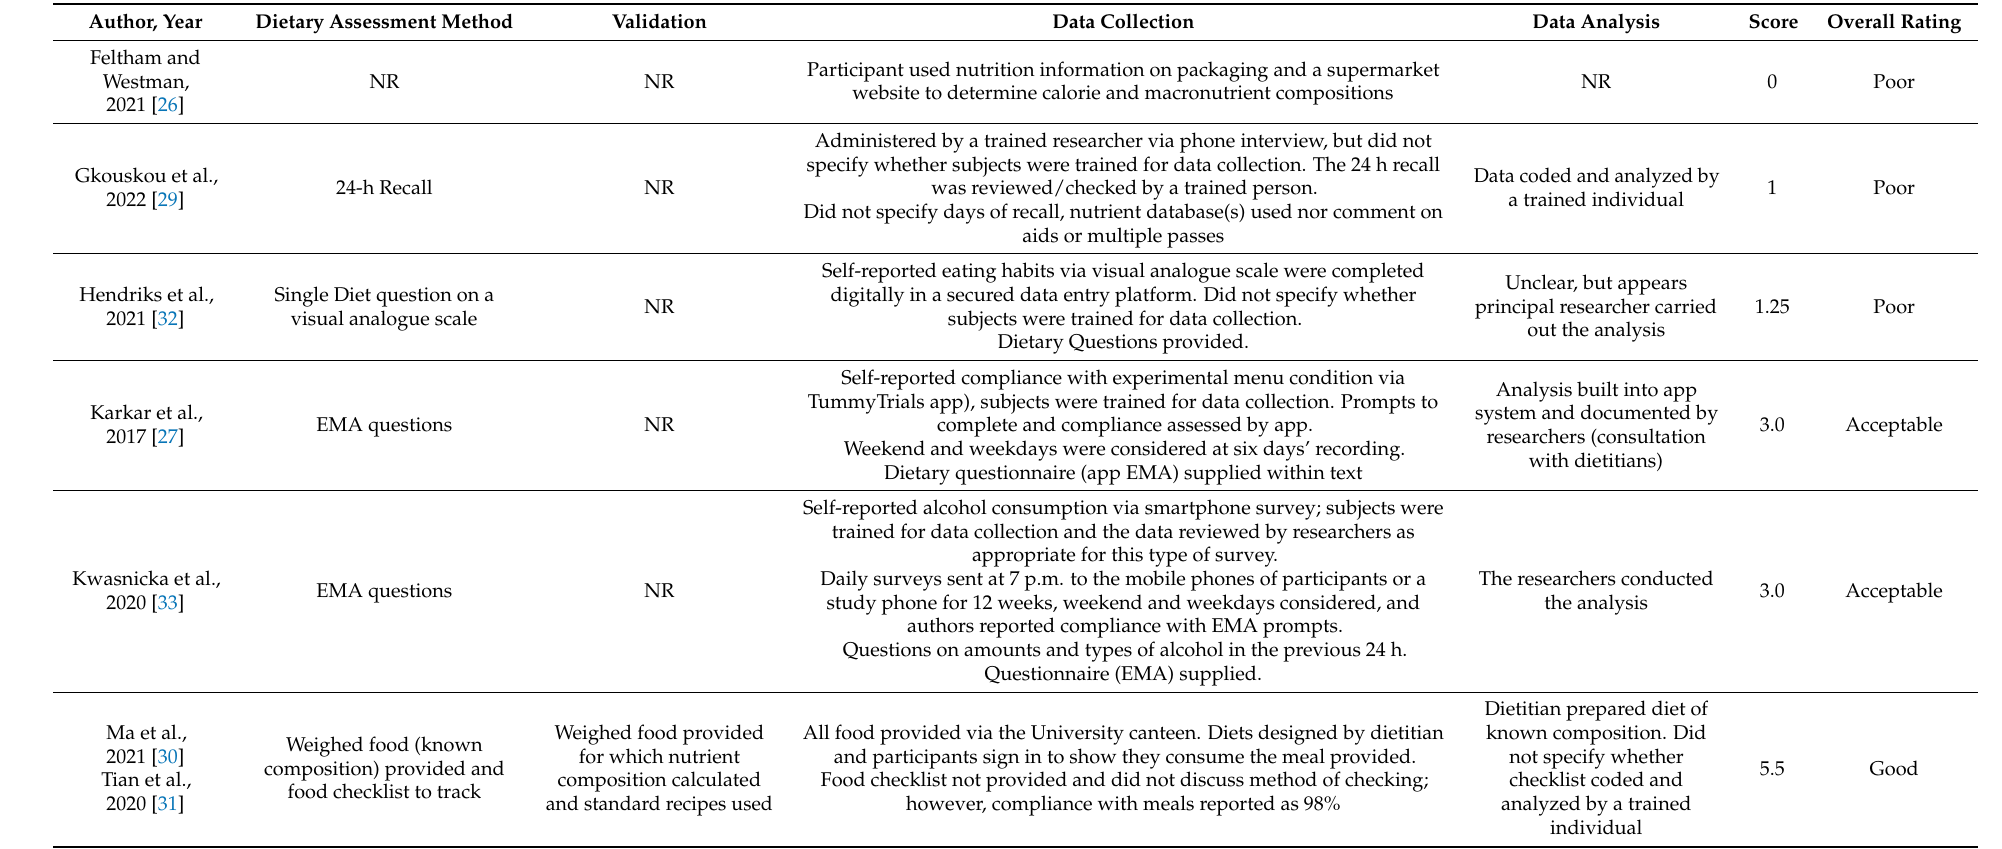
Table 3. Quality rating of reporting of dietary assessment method(s)